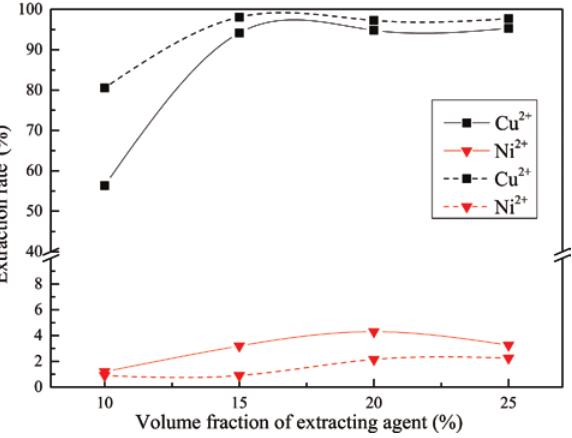
Figure 6: Effect of volume fraction of extracting agent on copper and nickel extraction rate. ( ) Microfluidic extraction: initial pH = 2.5, reaction time 1.95 s; ( ) Conventional extraction: initial pH = 2.5, oscillation frequency 300 rpm, contact time 60